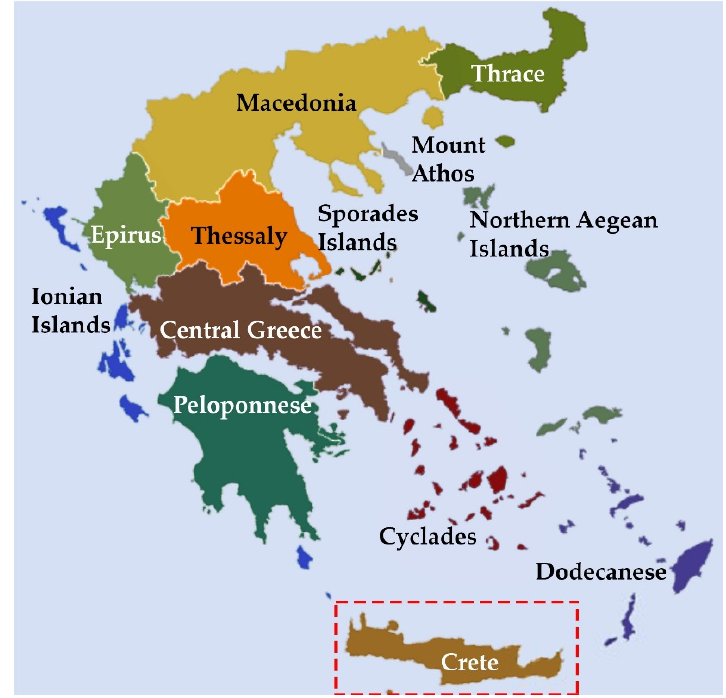
Figure 1. Location of Crete in relation to Greece (adapted from https://www.touropia.com/regions- of-greece-map/, accessed on 6 March 2022).